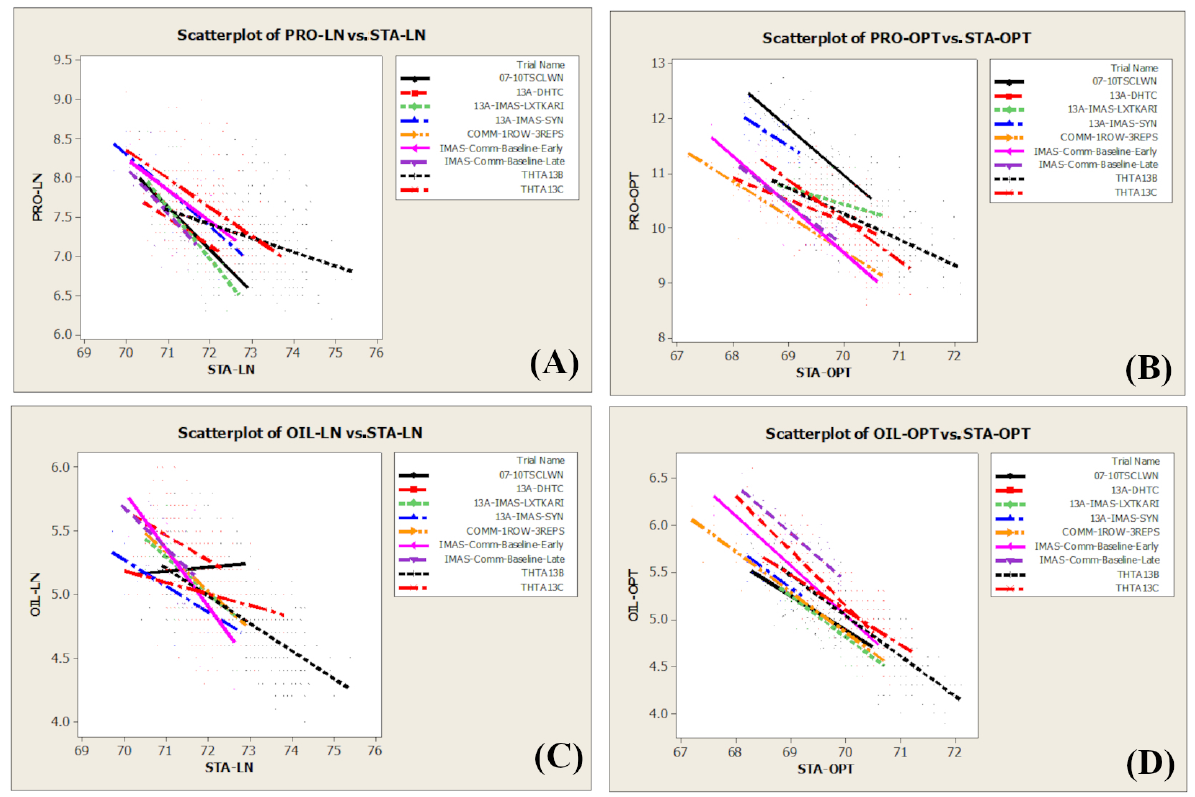
Figure 2. Scatter plots with regression lines showing the relationship between different quality traits in nine different trials conducted under optimum and severe N stress: ( A ) protein and starch content under low N, ( B ) protein and starch content under optimum conditions, ( C ) oil and starch content under low N and ( D ) oil and starch content under optimum conditions. OIL—oil